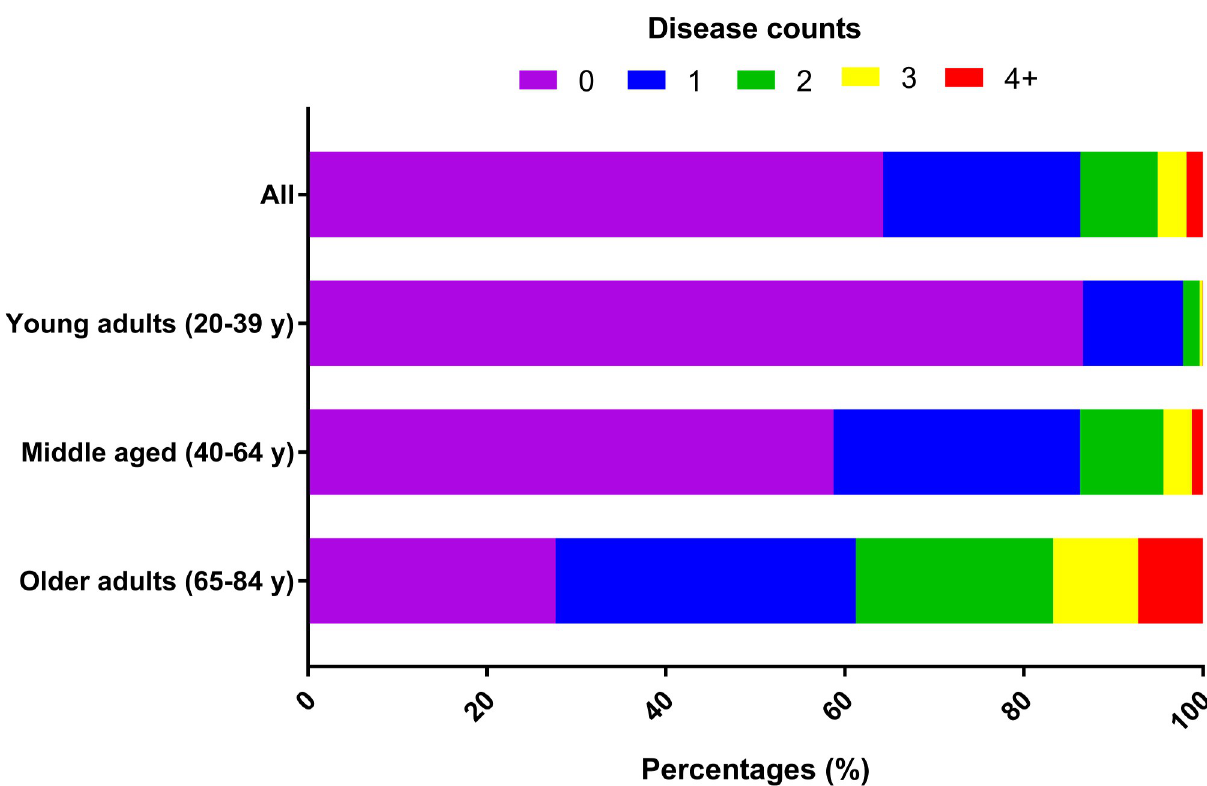
Fig 2. Frequency of disease counts overall and by age category. The y- axis depicts the various age groups. The x- axis represents the relative proportions of persons in each disease count category (designated by colors).